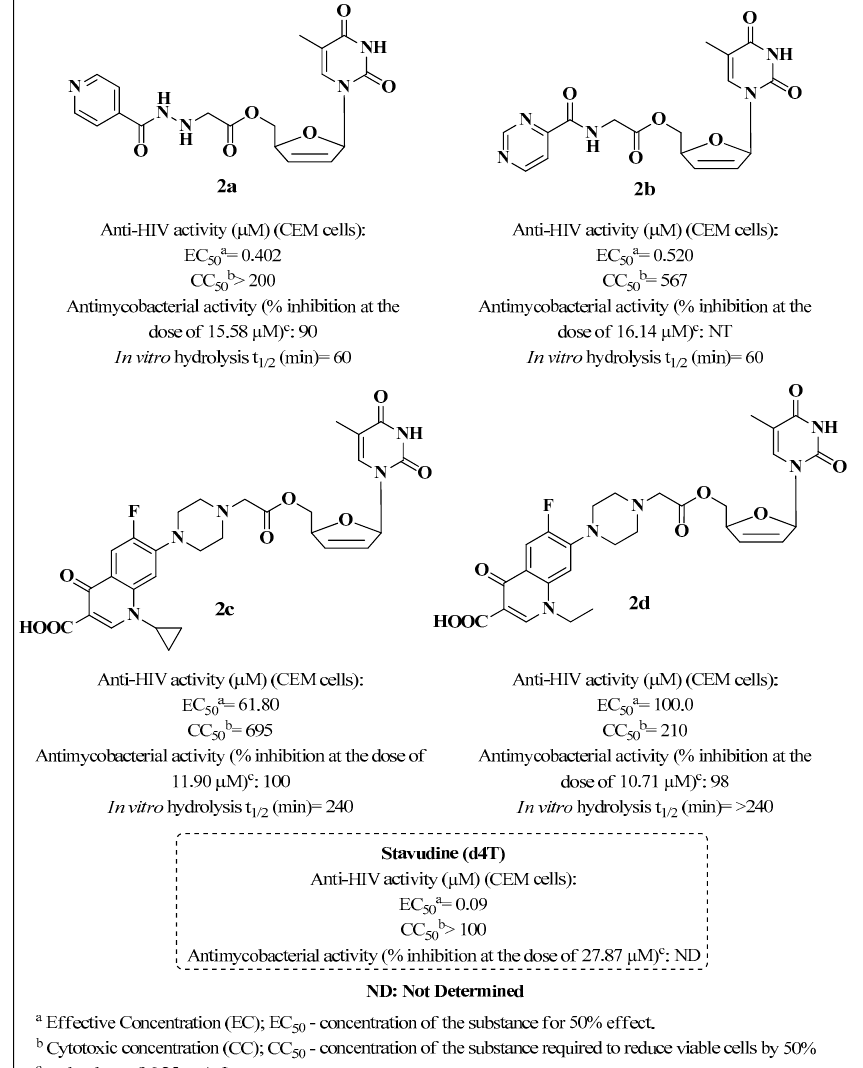
Molecules 2023 , 28 , x FOR PEER REVIEW Figure 6. Structural requirements for pyranocoumarins to exert anti-TB and anti-HIV activity [77]. Stavudine (d4T) is an NRTI used in anti-HIV therapy that has also been associated